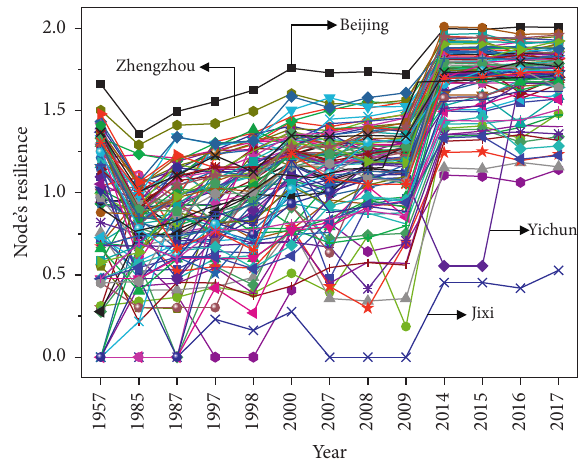
Figure 5: Evolution characteristics of city node resilience.